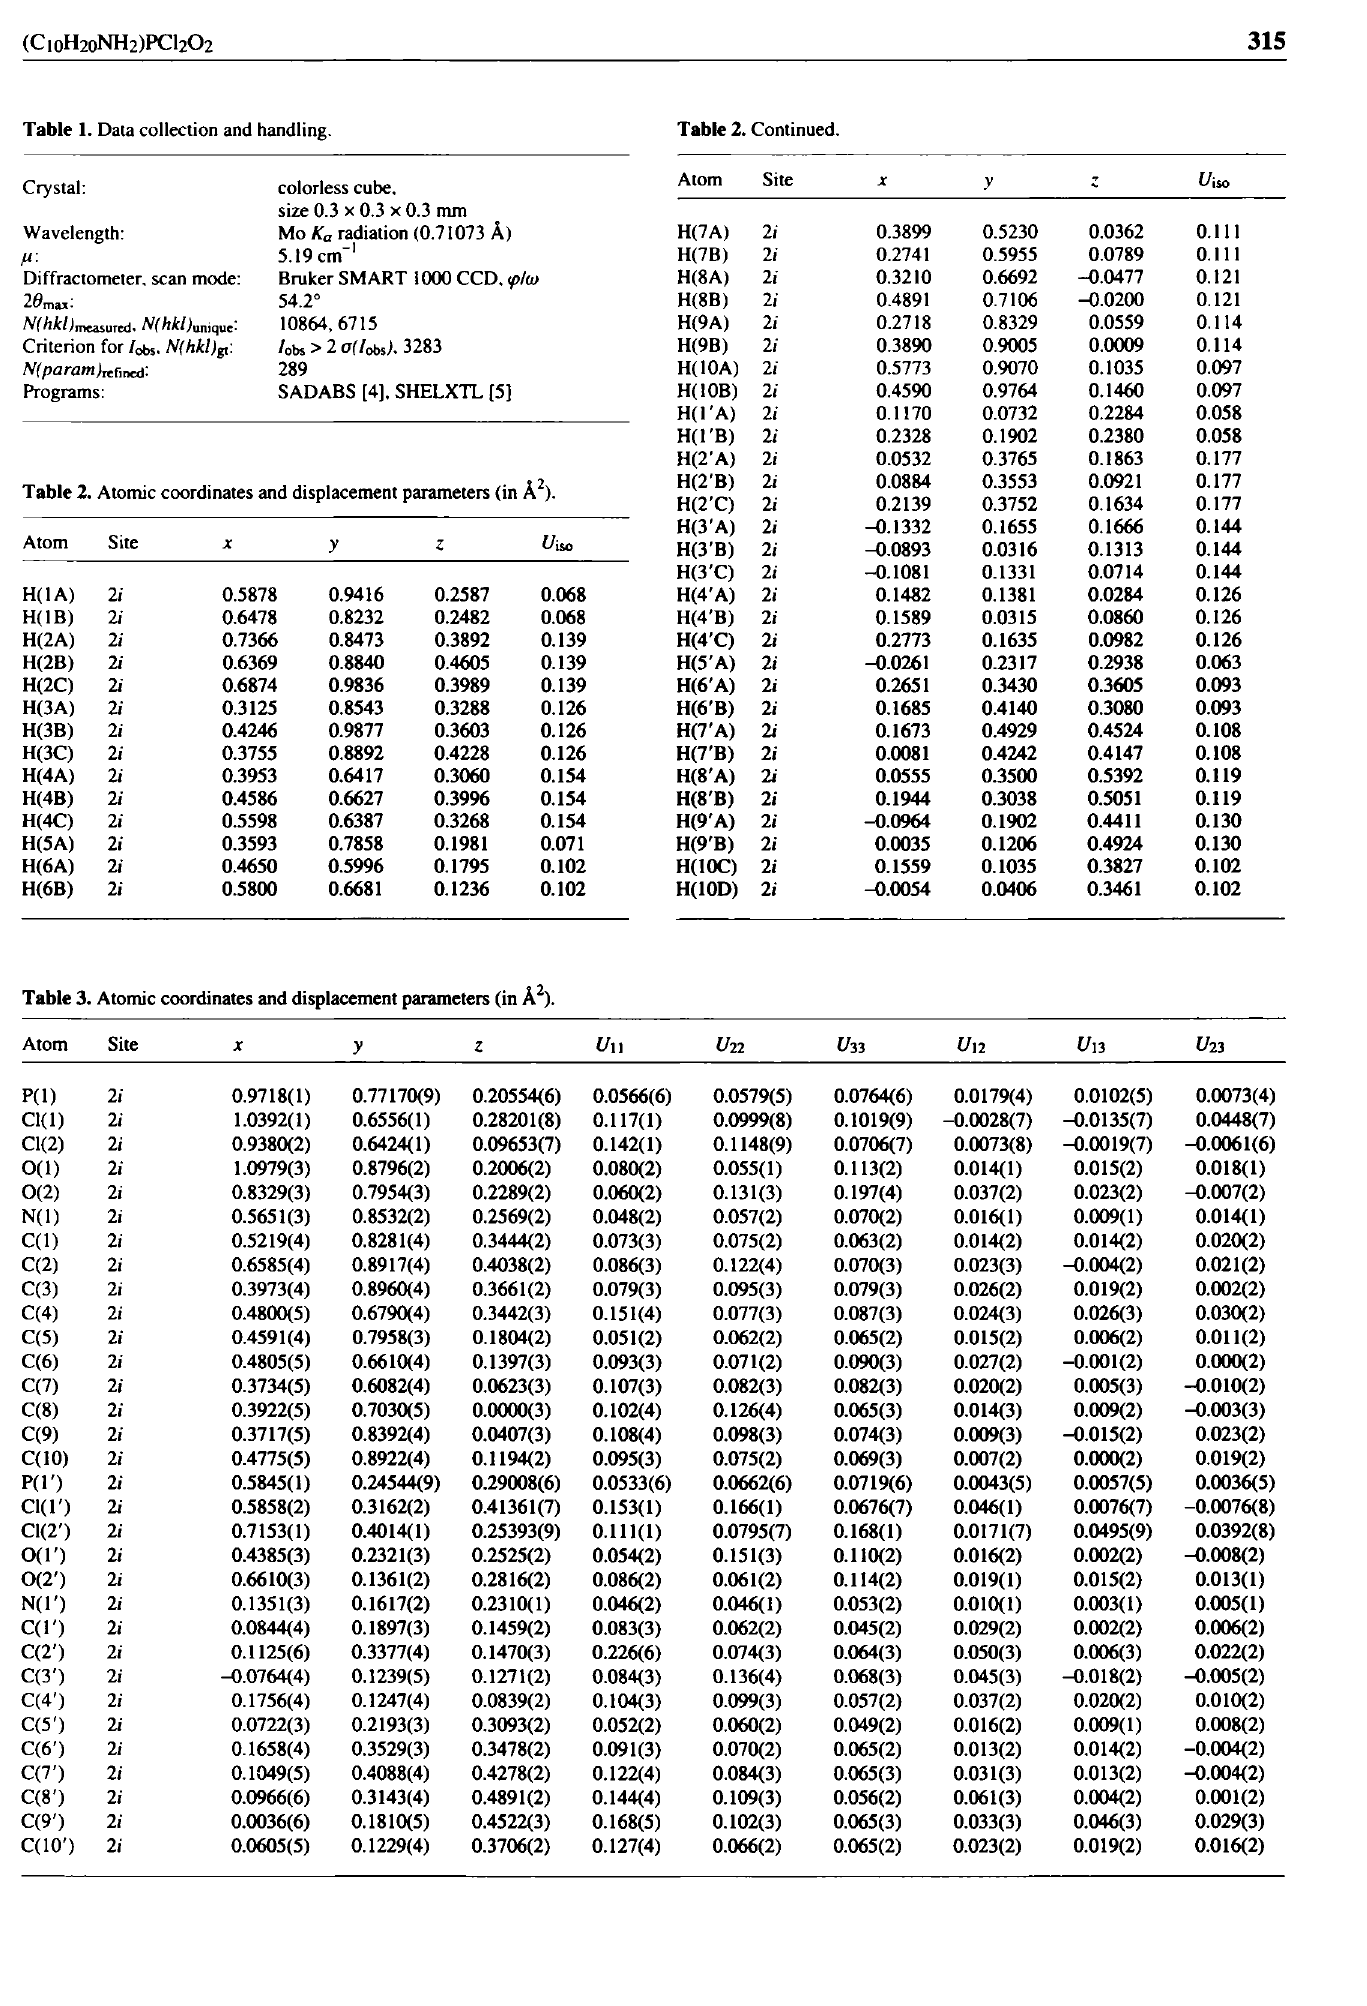
Table 3. Atomic coordinates and displacement parameters (in Â 2